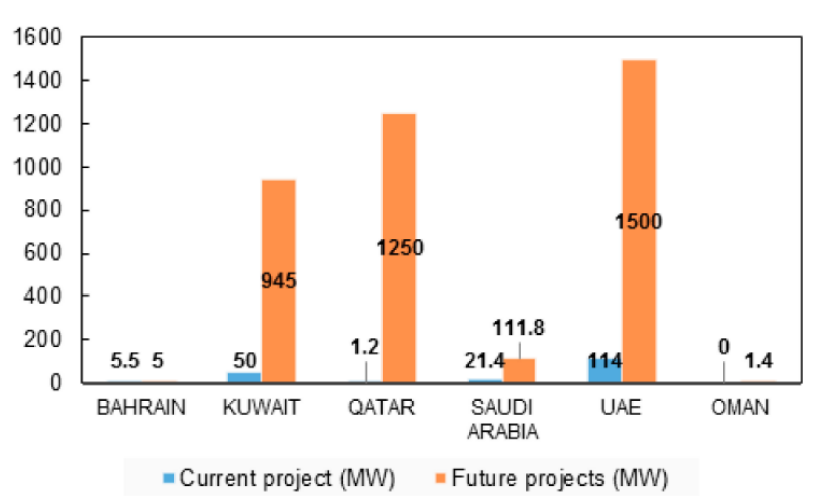
Figure 2: Current and future solar project in GCC (Masud et al., 2018)